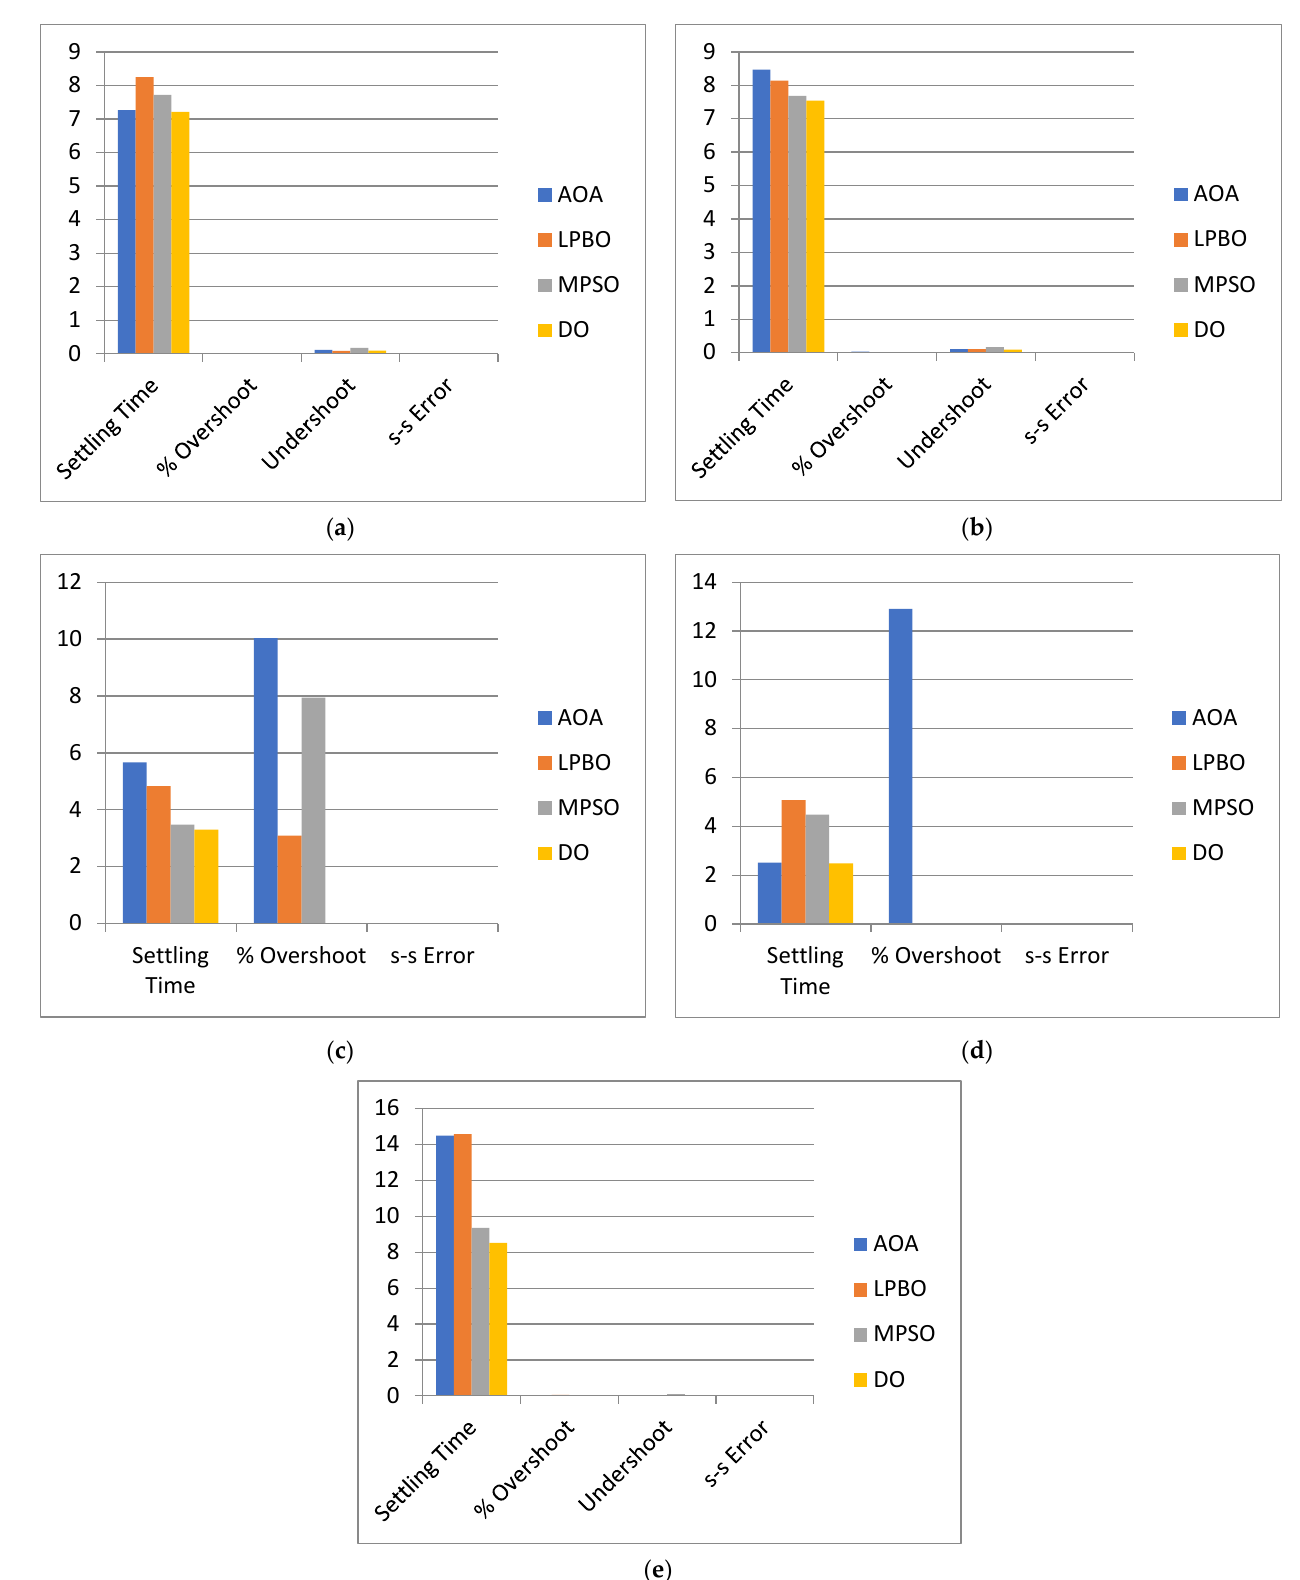
Figure 14. Graphical comparison in a two-area multi-source realistic IPS with nonlinearities. ( a ) ∆ f 1 ; ( b ) ∆ f 2 ; ( c ) V t1 ; ( d ) V t2 ; ( e ) P tie-line